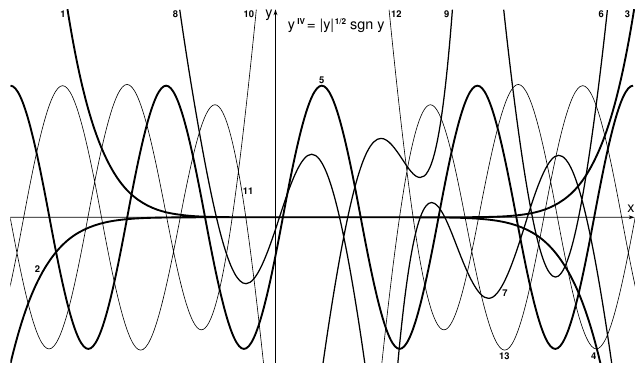
Figure 2. MU-solutions to equation